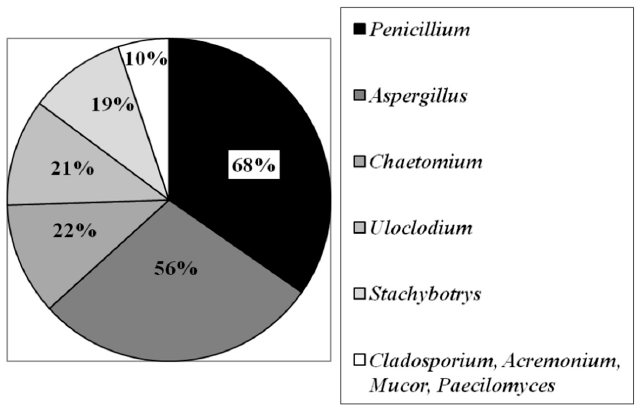
Figure 5. Most frequently insulated molds (with the highest percentage of occurrence) from walls and other surfaces [34].